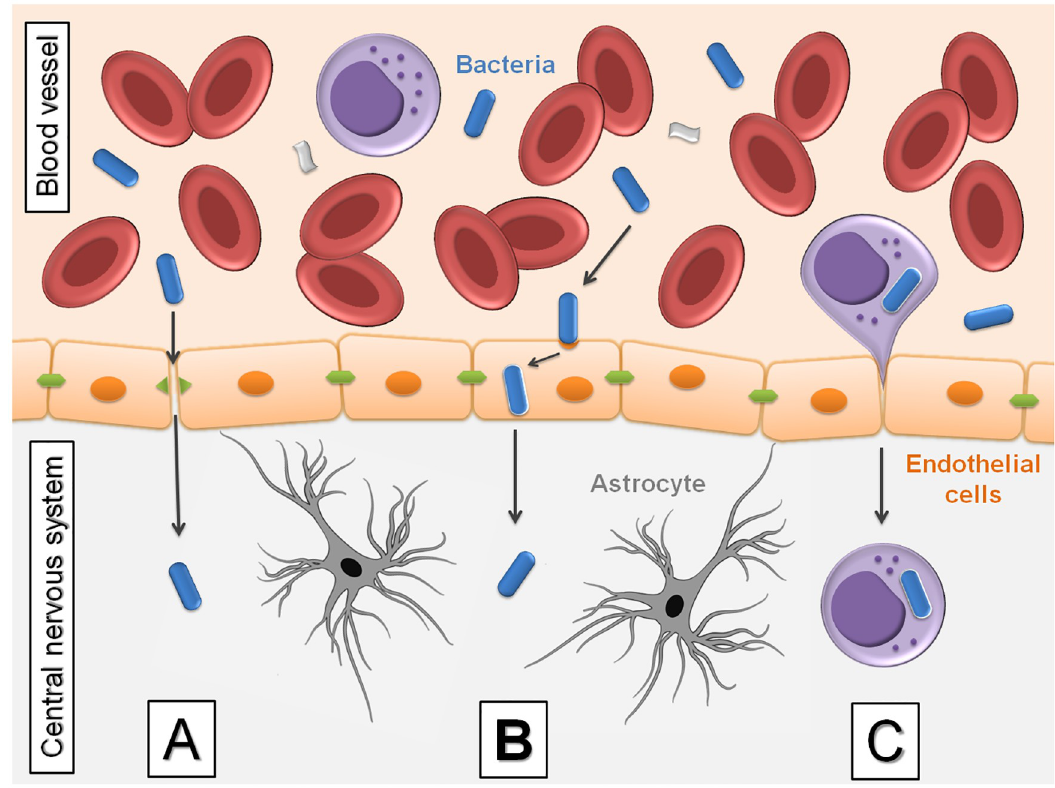
Fig 4. Mechanisms of bacterial penetration through the blood–brain barrier. (A) Intercellular or paracellular, described in extracellular pathogens. The physical barrier formed by endothelial tight junctions is disturbed by bacterial penetration. (B) Transcellular, passing through cells, e.g., direct invasion of endothelial cells. In this scenario, blood-borne bacteria directly invade CNS endothelial cells. (C) By leukocytes, within infected macrophages, named “Trojan horse” mechanism. Infected leukocytes adhere to endothelial cells, allowing the spread of bacteria or, alternatively, leukocytes can transmigrate and deliver bacteria to the CNS parenchyma. CNS, central nervous